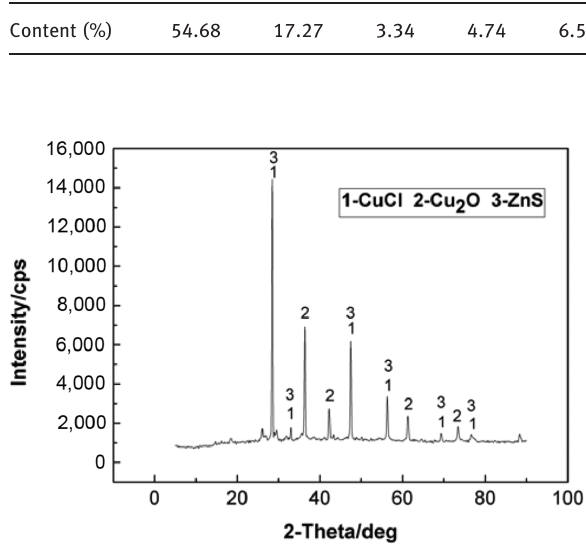
Figure 1: XRD patterns of the raw